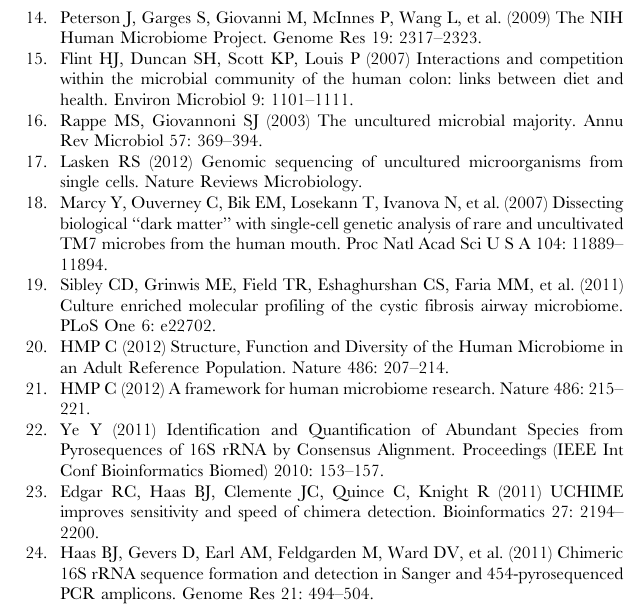
Table S1 Reference 16S sequence databases against which HMP OTUs were compared. Table S2 Non-HMP data sets against which HMP OTUs were compared. Table S3 Comparing species- (A) and genus-level (B) assignments to define percent identity cut-off values for prioritizing HMP OTUs. (See Document S2). Table S4 Comparison of single cell and HMP OTU consensus 16S sequences to identify ‘‘most wanted’’ single cells for whole genome sequencing. Document S1 Exploring high chimera rates among HMP OTUs. Document S2 Determining percent identity